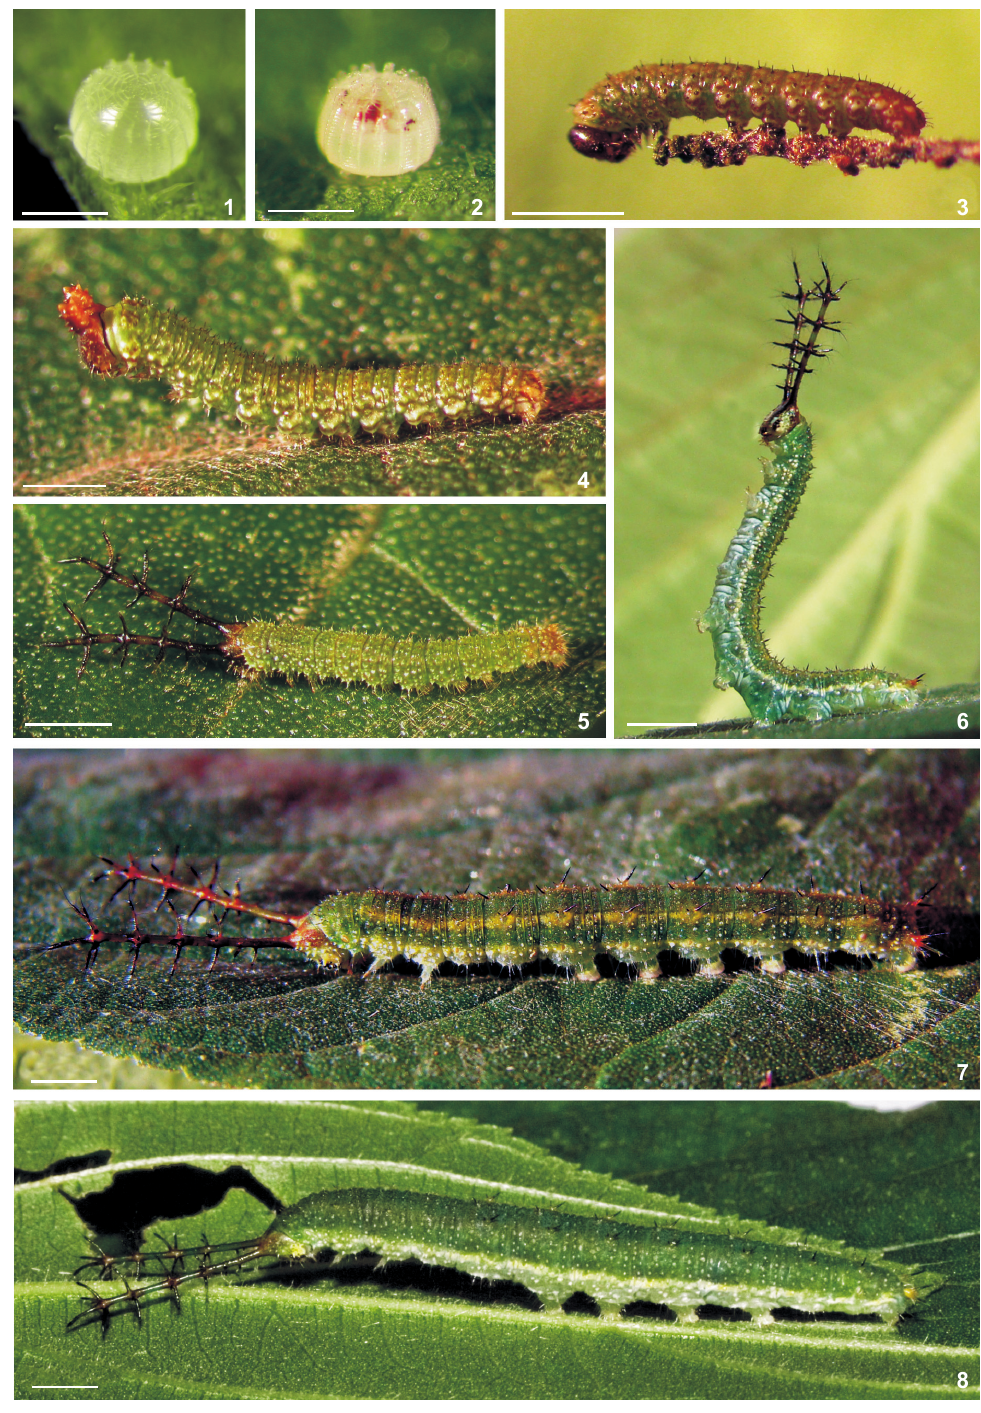
Figures 1-8. Immature stages of Diaethria clymena janeira : (1) newly laid egg, dorsal view; (2) mature egg, lateral view; (3) first instar at the tip of a frass-chain; (4) second instar; (5) third instar; (6) fourth instar in defensive posture; (7) fifth instar, latero-dorsal view; (8) fifth instar, prepupa, lateral view. Scale bars: 1-2 = 0.5 mm, 3-4 = 1.0 mm, 5 = 1.5 mm, 6-8 = 2.5 ZOOLOGIA 27 (5): 696–702, October, 2010